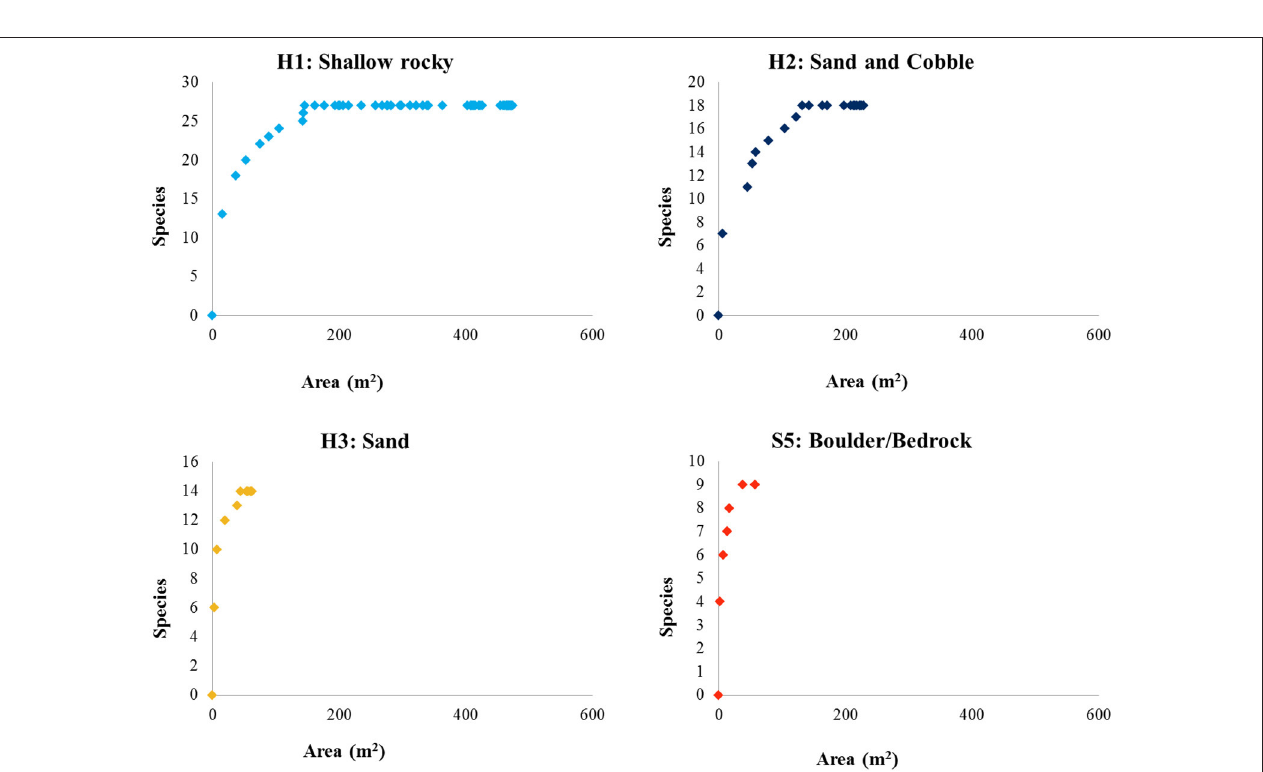
FIGURE 8 | Species-area curves of fauna identified from seafloor video within the mapped habitats of the Eastport MPA.